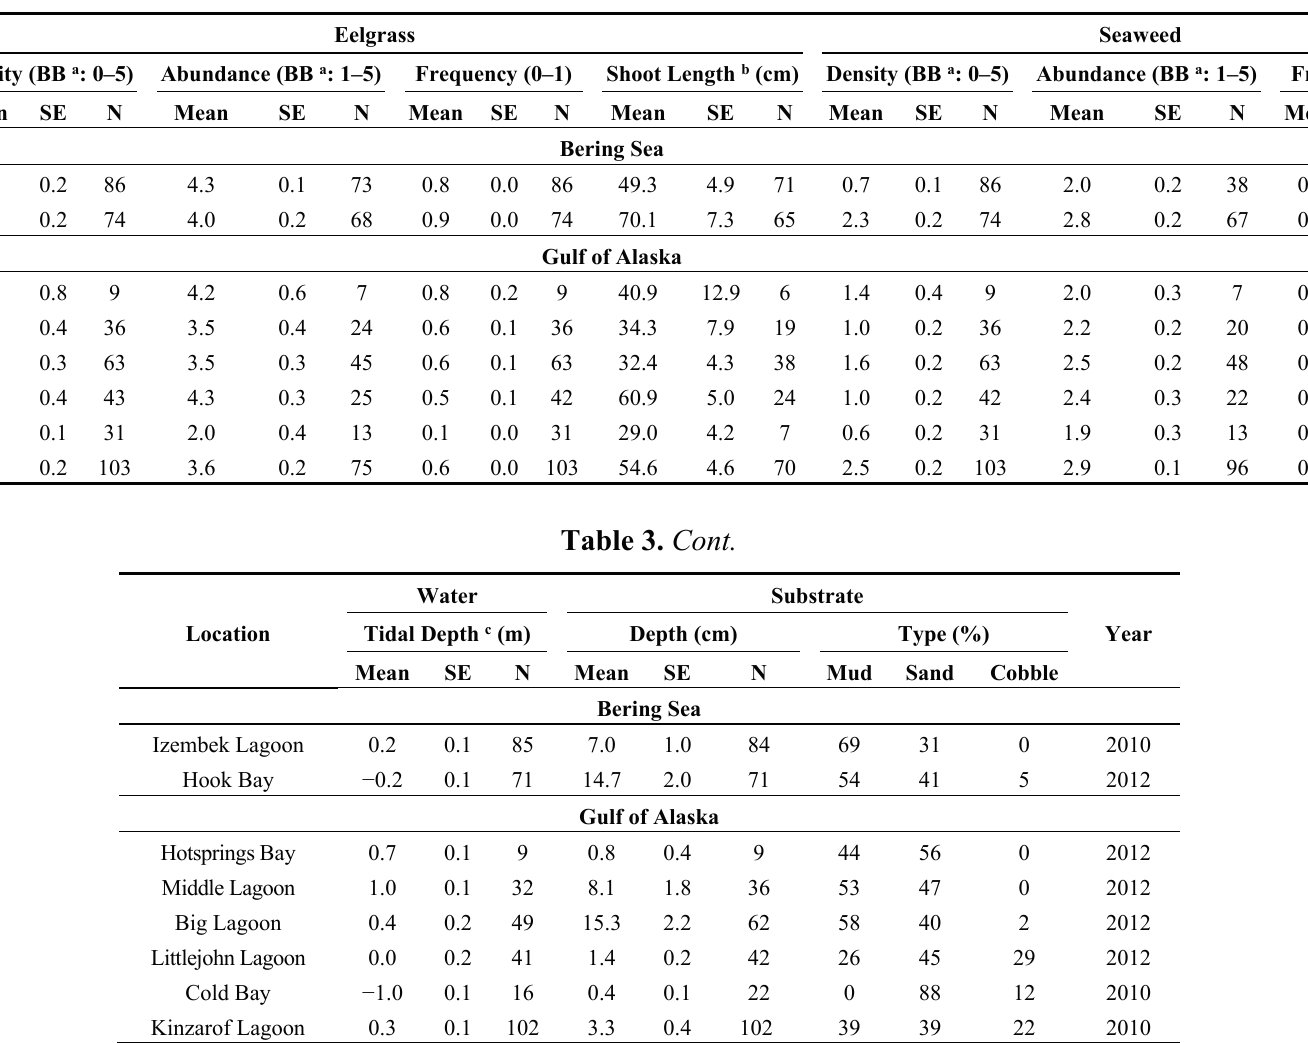
Table 3. Variation of eelgrass and seaweed characteristics and environmental parameters in selected embayments on the lower Alaska Peninsula,